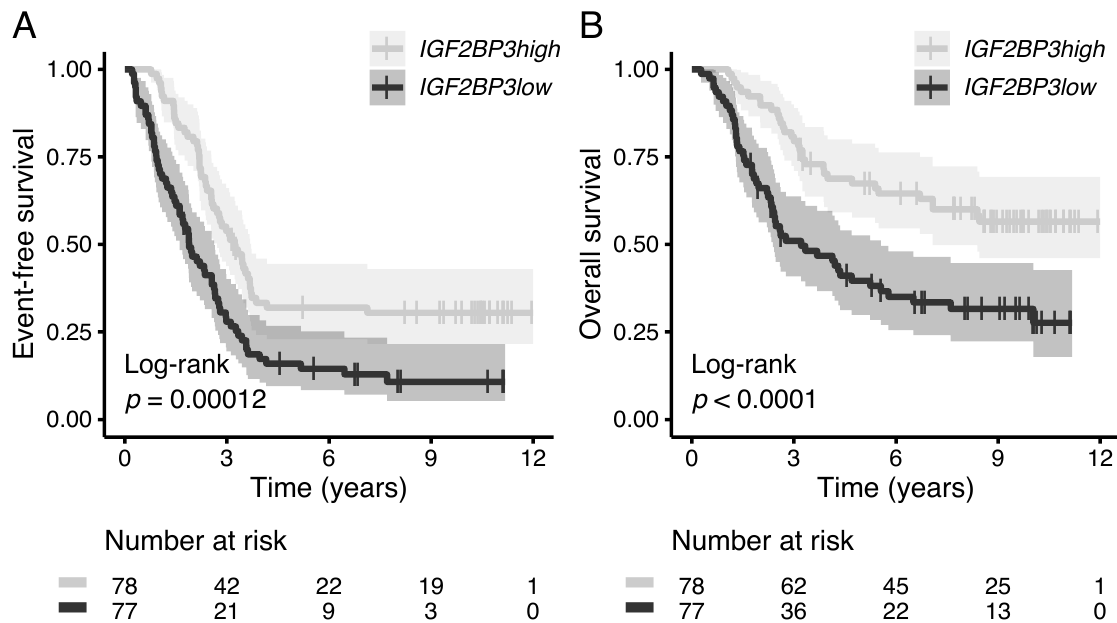
Figure 4. Association of IGF2BP3 expression at an mRNA level on patient survival. Kaplan–Meier survival analysis for ( A ) event-free survival and ( B ) overall survival in the high-risk B-ALL TARGET cohort ( n = 155) [27,28]. Statistical significance was tested using the log-rank test, while the median expression of IGF2BP3 was used as a cut-off for the two different patient